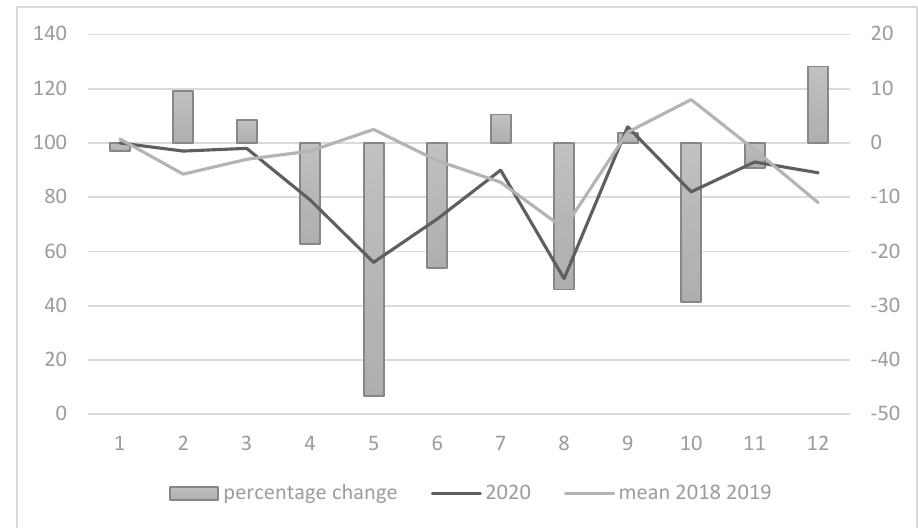
Figure 1. Monthly differences in colorectal cancer admissions.